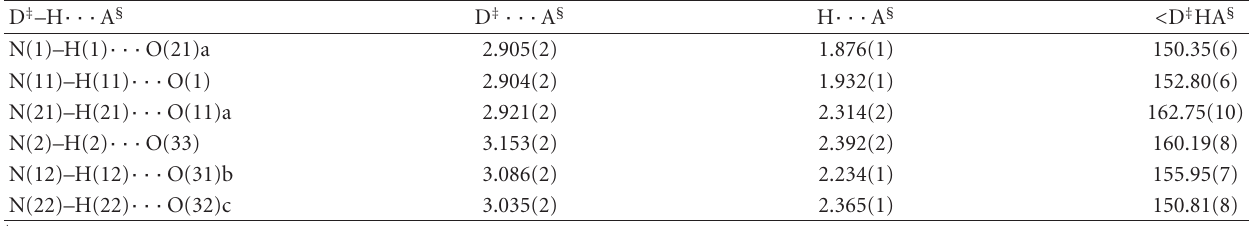
Table 9: Dimensions of the unique hydrogen bonds (distances in ˚A and angles in ◦ ) for complex 4 . †